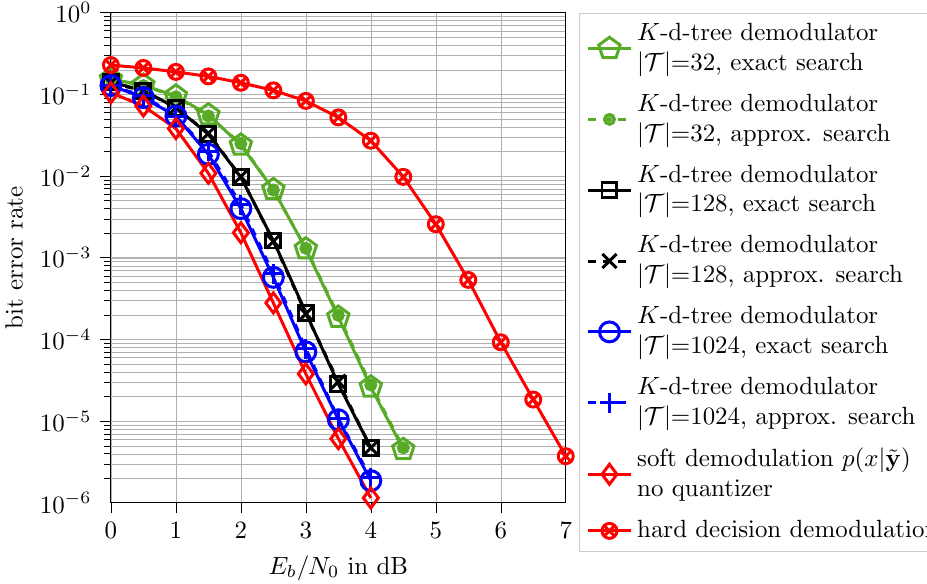
Figure 10. Bit error rate results for non-binary GF ( 8 ) low-density parity-check encoded data transmis- sion over an AWGN channel with the parameters mentioned in Table 2. The proposed K -dimensional tree demodulators can achieve performance very close to the considered optimum reference